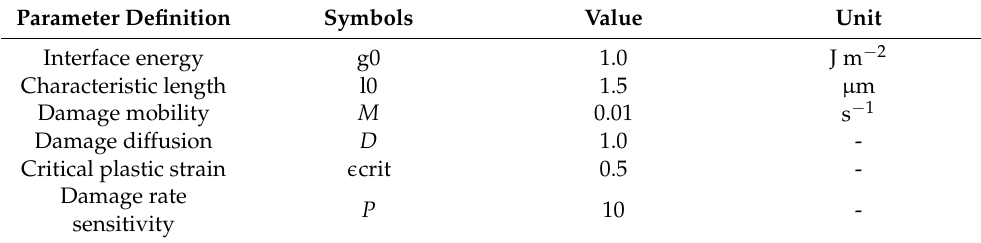
Table A4. Physical and fitting damage parameter values used for the ferrite phase, adopted from the